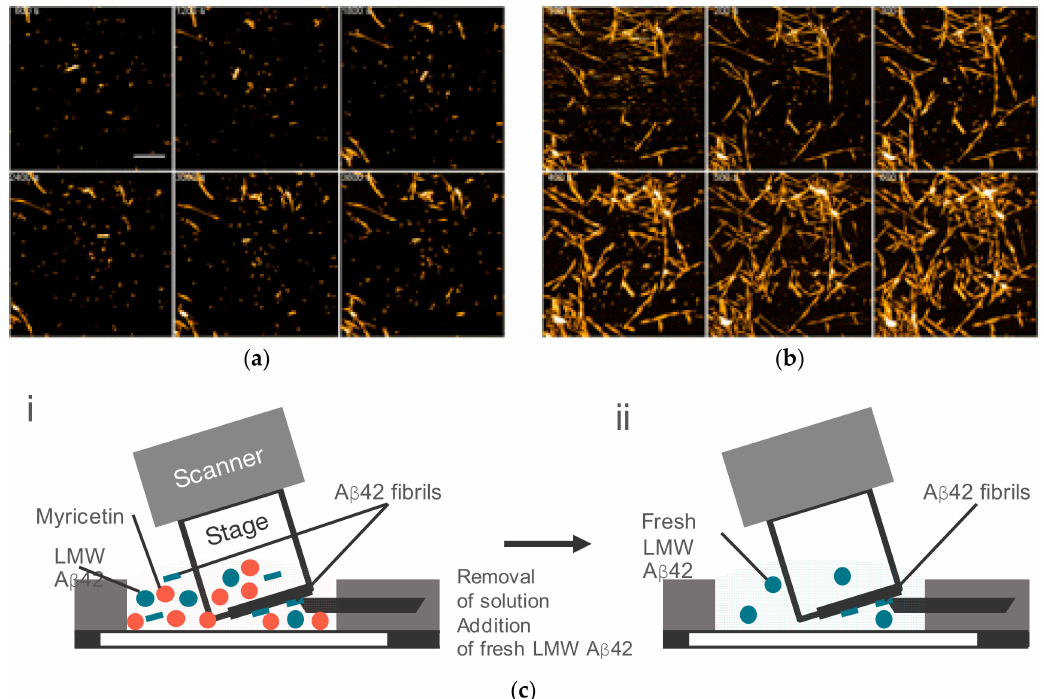
Figure 11. HS-AFM observation of A β 42 fibril growth in the presence / absence of myricetin. ( a ) HS-AFM images of LMW A β 42 incubation with fibril seeds and myricetin at the indicated time after the addition of 0.1 M NaCl. Scale bar, 300 nm. ( b ) HS-AFM images of the same observation area after the replacement of the solution to fresh LMW A β 42. ( c ) Schematic views of HS-AFM observation condition (i) and (ii) correspond to ( a ) and ( b ) Reproduced from